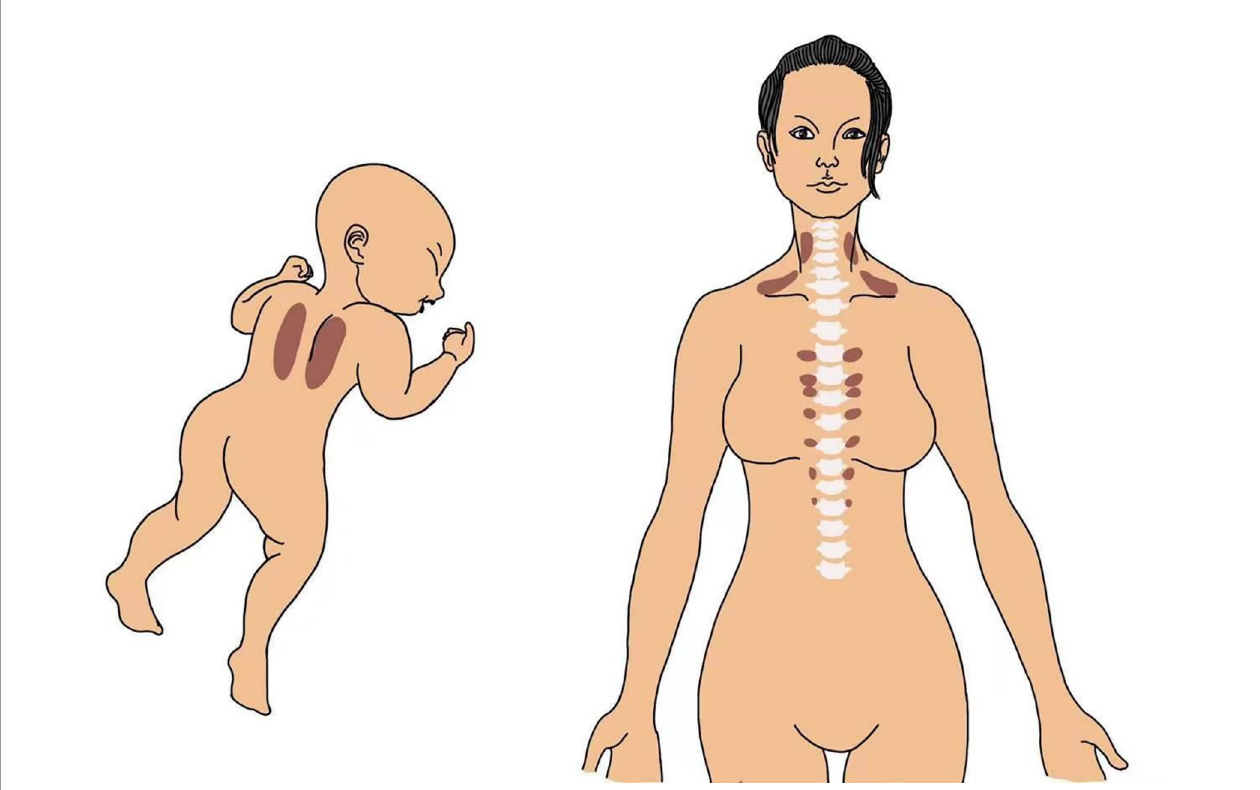
FIGURE 1 | A drawing showing representative BAT occurrence in the interscapular region in an infant and in the supraclavicular, cervical, and paravertebral regions in an adult